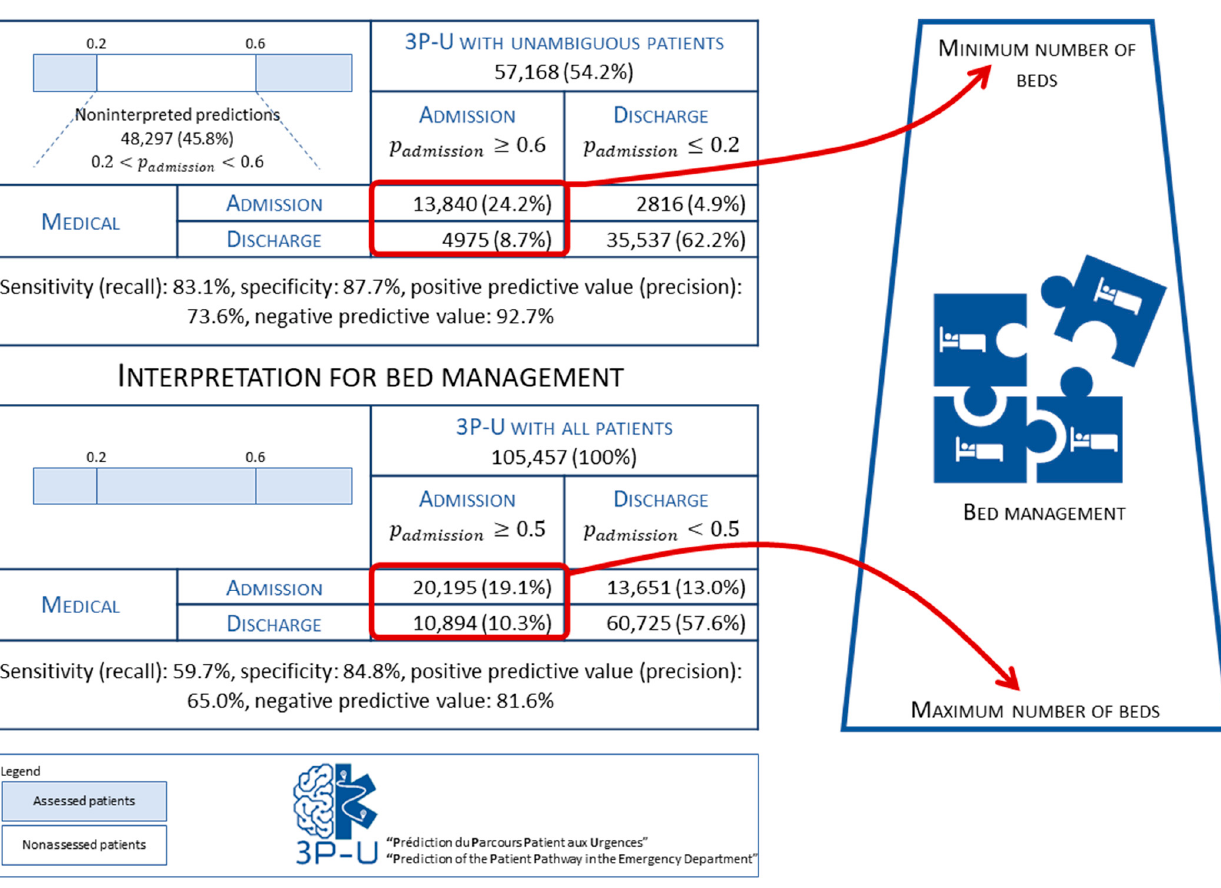
Figure 2. The 3P-U model’s performance and the bed manager’s interpretation.